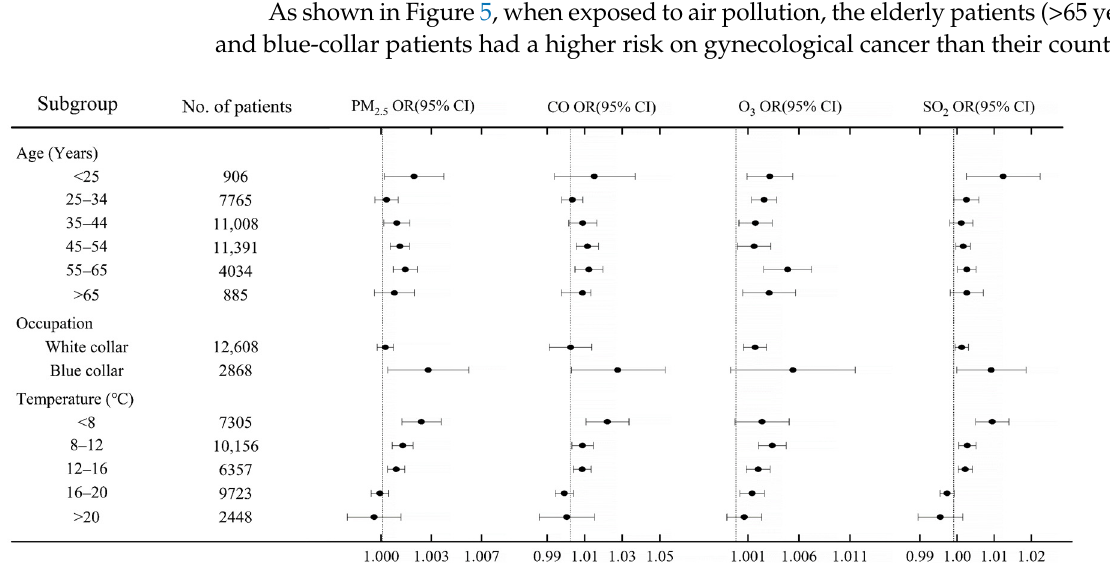
Figure 5. Relationship between air pollution and gynecological cancer with different social and demographic characteristics. The risks of four air pollutants on the risk of gynecological cancers is evaluated in each subgroup with PM 2.5 , O 3 , and SO 2 increase by 1.0 μ g/m 3 and CO increase by 1.0 mg/m 3 .